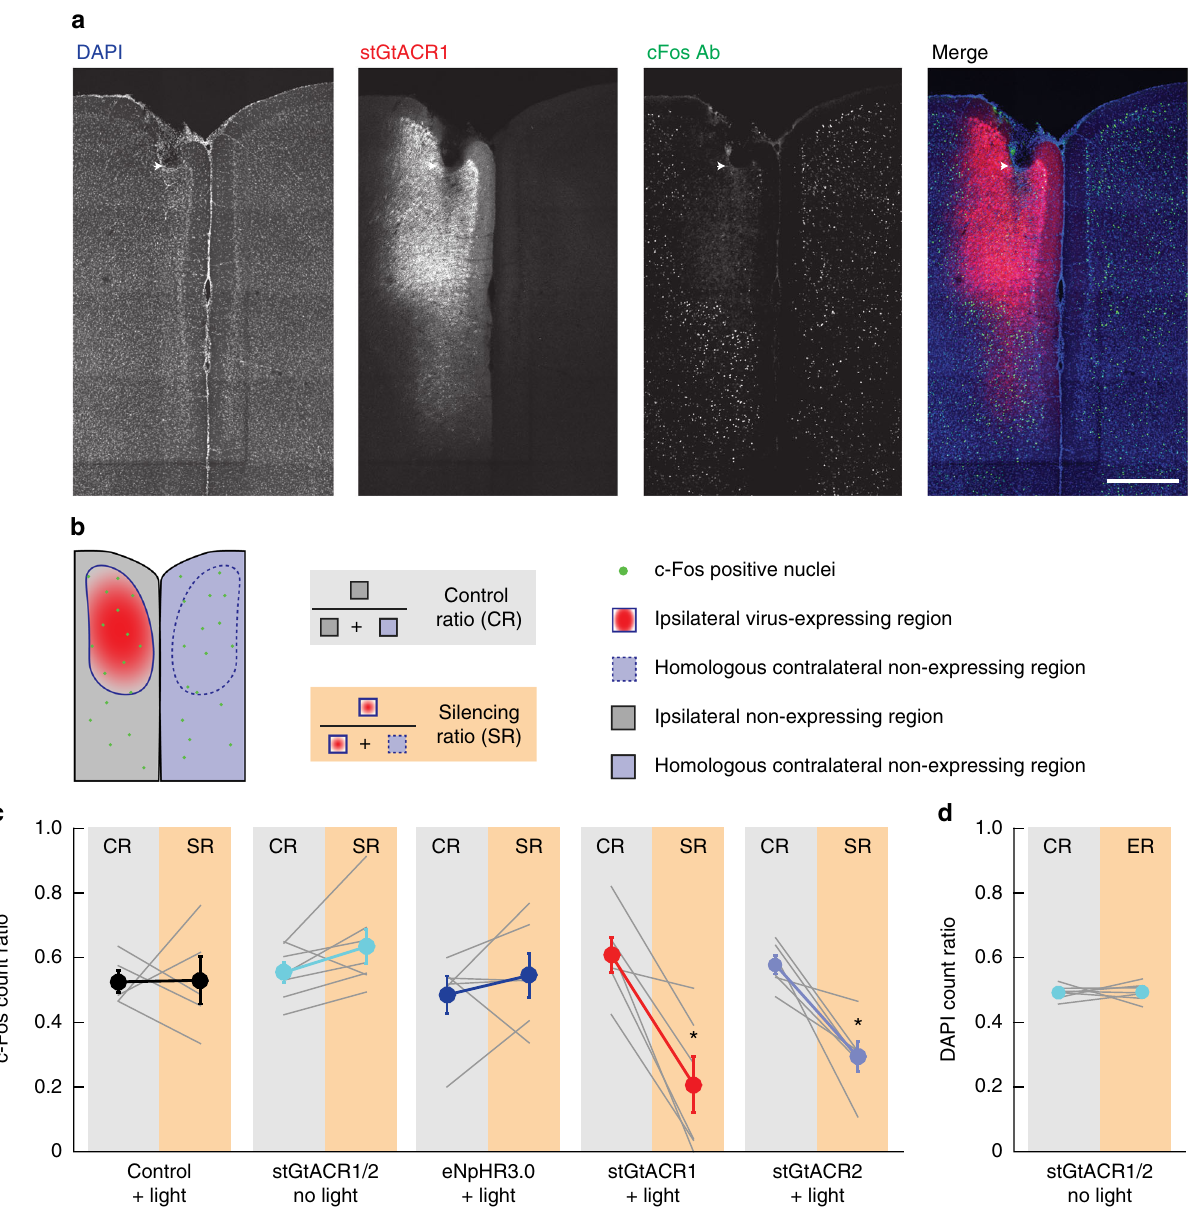
Fig. 7 Soma-targeted GtACRs allow widespread cortical silencing. a Representative images of c-Fos expression in a mouse expressing stGtACR1, which was illuminated with yellow light (593 nm, 6 mW) during enriched environment exposure. c-Fos expression 69 in the area surrounding the optic fi ber implant (white arrow) was reduced. Scale bar, 500 µ m. b Schematic of the quanti fi cation of change in the number of detected c-Fos-positive nuclei. The ipsilateral region was divided to AAV-expressing regions and regions showing no expression. The number of detected c-Fos-positive nuclei was then normalized to the sum of c-Fos-positive nuclei in a given region (i.e., either the expressing or non-expressing regions in the AAV-injected hemisphere) and its homologous contralateral non-expressing region, resulting in a ratio ranging from 0 (all detected c-Fos-positive nuclei are on the contralateral side) to 1 (all detected c- Fos-positive nuclei are on the ipsilateral side). This normalization was meant to correct for variability in the density of c-Fos-positive nuclei across different mPFC regions. If c-Fos expression is equal across hemispheres, a ratio of 0.5 is expected. c Measured effects under the following conditions from left to right: Light delivery (593 nm, n = 3 or 460 nm, n = 2; light at 6 mW) in fl uorophore-expressing control mice ( t = − 0.05, n = 5, p = 0.96); No light delivery in stGtACR1- ( n = 3) and stGtACR2-expressing ( n = 4) mice ( t = − 1.9, n = 7, p = 0.32); Illumination with 593nm light at 6 mW in eNpHR3.0-expressing mice ( t = − 0.88, n = 6, p = 0.84); Illumination with 593nm light at 6 mW in stGtACR1-expressing mice ( t = 5.2, n = 5, p = 1.78*10 − 2 ); Illumination with 460 nm light at 6 mW in stGtACR2-expressing mice ( t = 4.6, n = 6, p = 2.28 × 10 − 2 ). Reported p -values are based on paired t -tests with Holm – Bonferroni correction. d Ratio of DAPI nuclei counts in non-expressing ipsilateral regions (CR) and expressing ipsilateral regions (ER) calculated as explained in b for c-Fos counts (stGtACR1, n = 3; stGtACR, n = 4; paired-sample t -test, t = − 0.1, n = 7, p = 0.92). All results are presented as mean ±